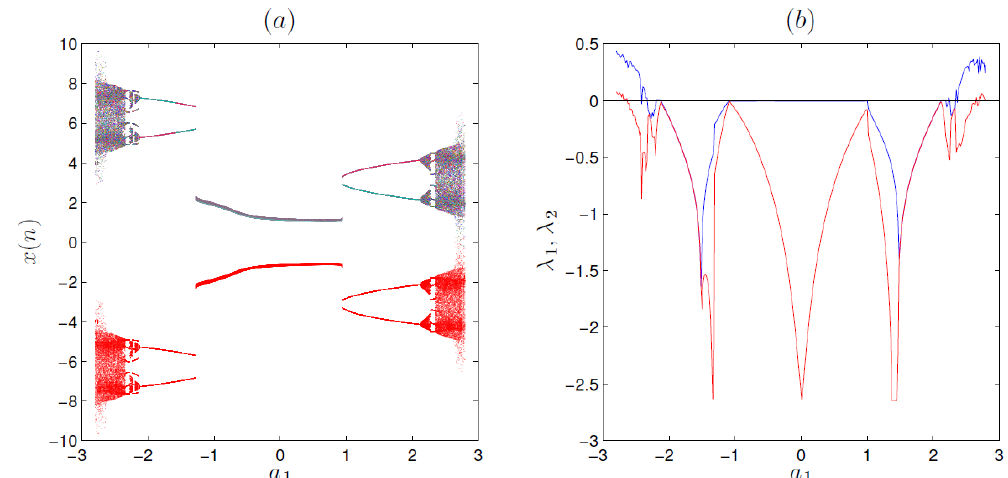
Figure 2. ( a ) Bifurcation diagram and ( b ) Lyapunov exponents of the fractional memristor map (12) with infinite fixed points for order α = 0.99 and system parameter a 2 = 1.1, a 3 = 0 and ICs ( 1,2 ) and ( − 1, − 2 )